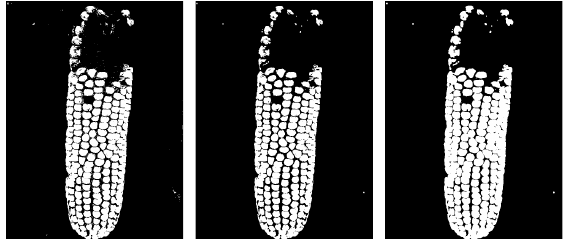
Figure 6. Corroding and expanding of recognized